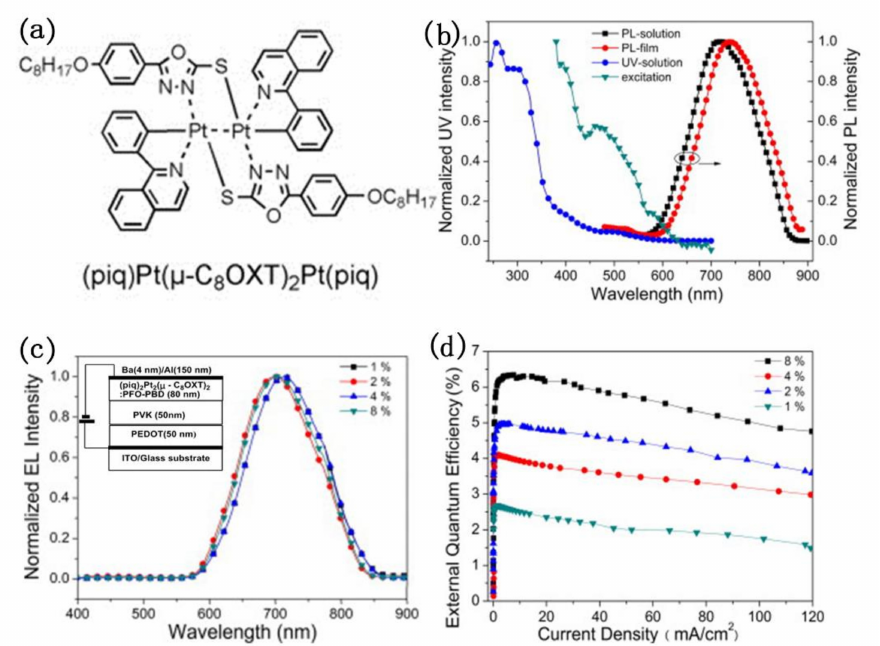
Figure 14. ( a ) The structure of (piq) 2 Pt 2 ( µ -C 8 OXT) 2 ; ( b ) Absorption and PL spectra of (piq) 2 Pt 2 ( µ - C 8 OXT) 2 ; ( c ) EL spectra and ( d ) EQE curves of the (piq) 2 Pt 2 ( µ -C 8 OXT) 2 -doped PFO–PBD devices with different dopant concentrations. Insert: ( c ) The diagram of the EL devices. Reprinted from [82]. Copyright 2012, with permission from Elsevier.